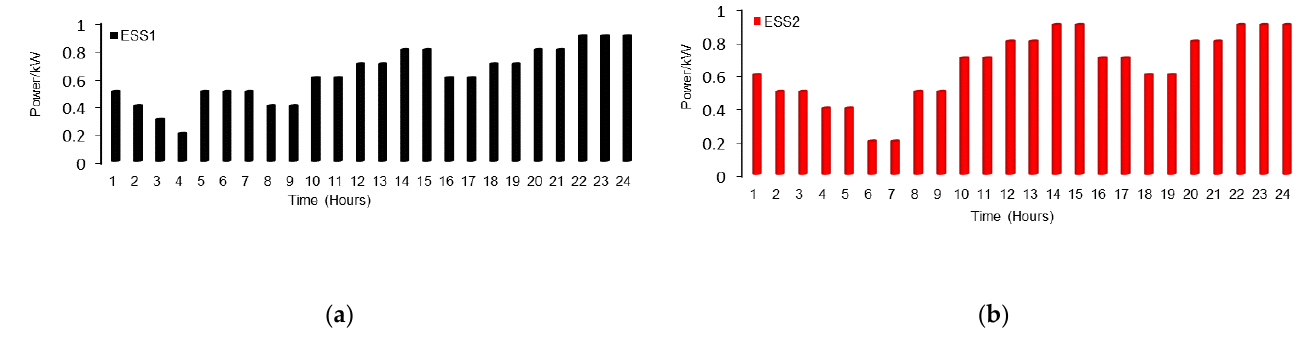
Figure 9. ( a , b ). shows State of charge profiles of ESS1 &